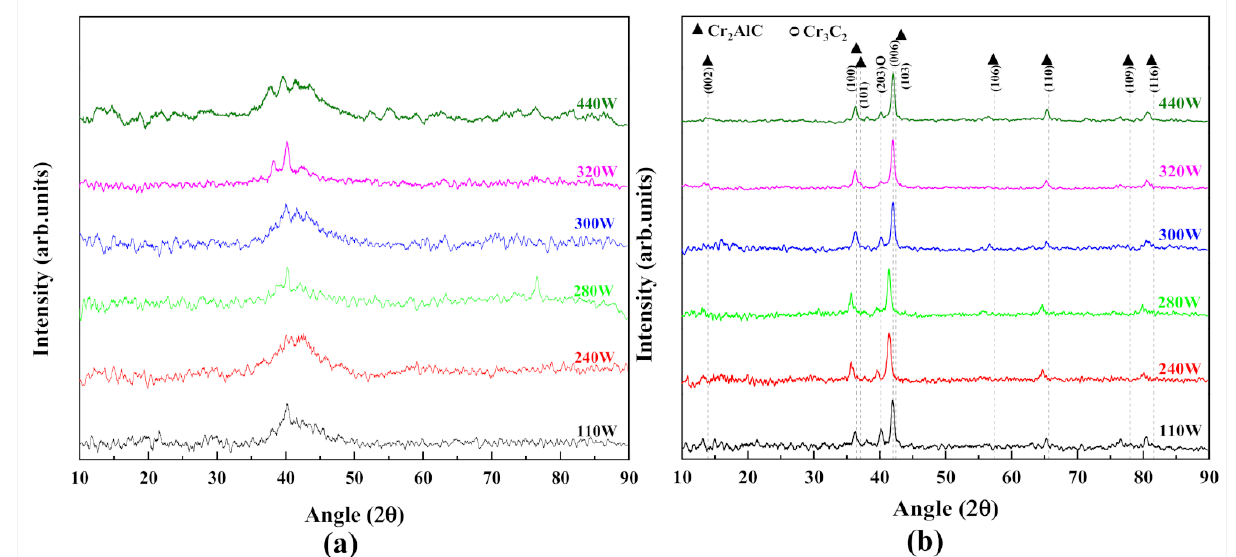
Figure 4. Grazing incidence XRD patterns of ( a ) as-deposited and ( b ) annealed Cr 2 AlC MAX phase coatings synthesized at different average power.